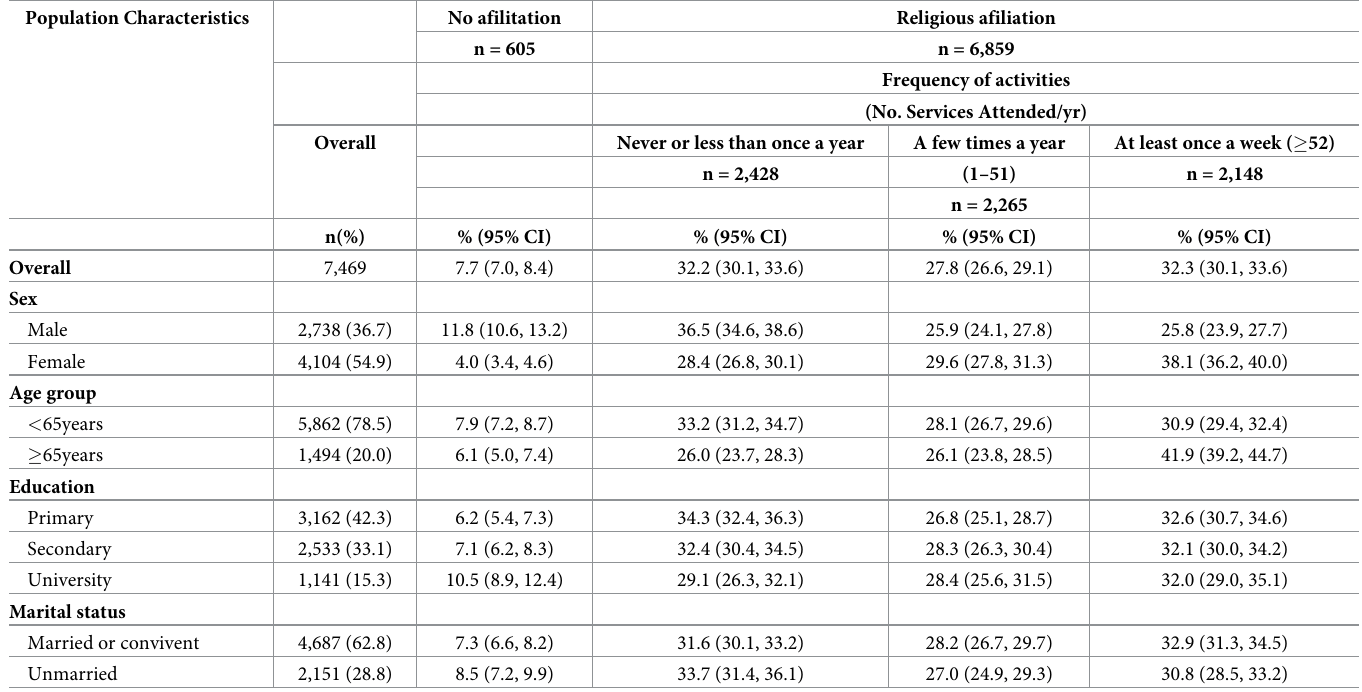
Table 1. Frequency distribution of religious activities by population